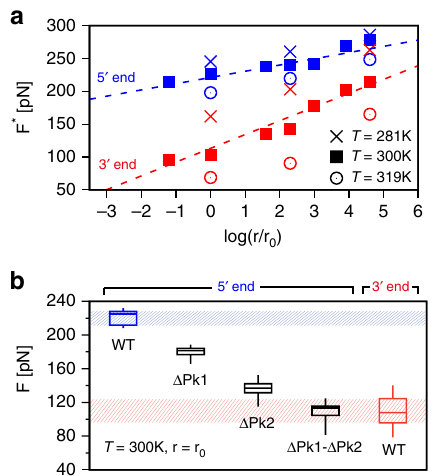
Fig. 3 Critical translocation forces for different conditions and variants of Zika xrRNA. a Most probable translocation forces from the 5 0 and 3 0 ends at different temperatures, T , and force-ramping rates, r ; the estimated errors are smaller than the symbols. For clarity only a subset of all considered ( T , r ) combinations are shown, see Supplementary Fig. 7. The dashed lines show the Bell – Evans relation of Eq. (1) for T = 300 K with parameters fi tted simultaneously on all ( T , r ) datapoints, see main text. b Box – whisker plots (center line, median ; box limits, upper and lower quartiles) for the translocation forces at T = 300 K and r = r 0 , for the native (WT) xrRNA (5 0 and 3 0 entries) and for three variants lacking the native contacts in Pk1 and/or Pk2 (5 0